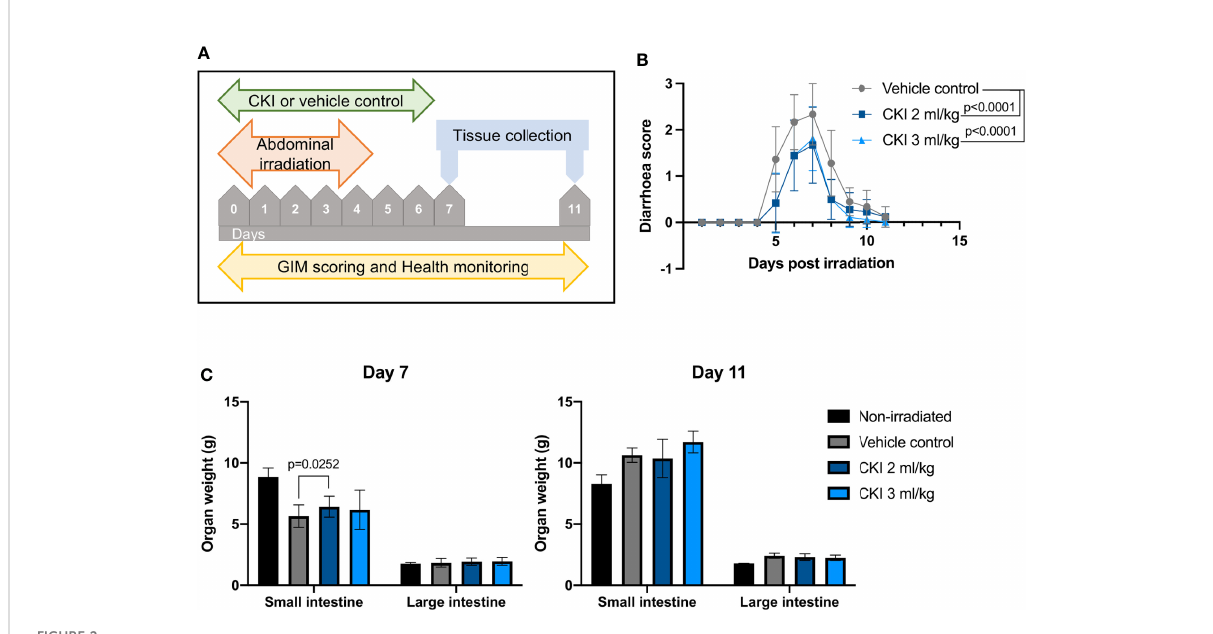
FIGURE 2 Administration of CKI reduces the severity of radiation-induced GIM. (A) Schematic representation of the experimental timeline. (B) Diarrhea scores of irradiated SD rats. Rats received fi ve fractions of radiation on their abdomen and were concurrently treated with CKI or vehicle control. (C) Weight of the intestines of irradiated rats on day 7 (left) and day 11 (right). Rats were euthanized on day 7 and day 11 post initial irradiation and small and large intestines were collected and weighed. Data are presented as mean ±